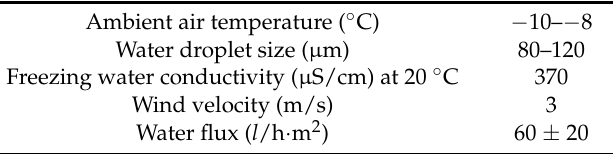
Table 2. Parameters of ice accretion.